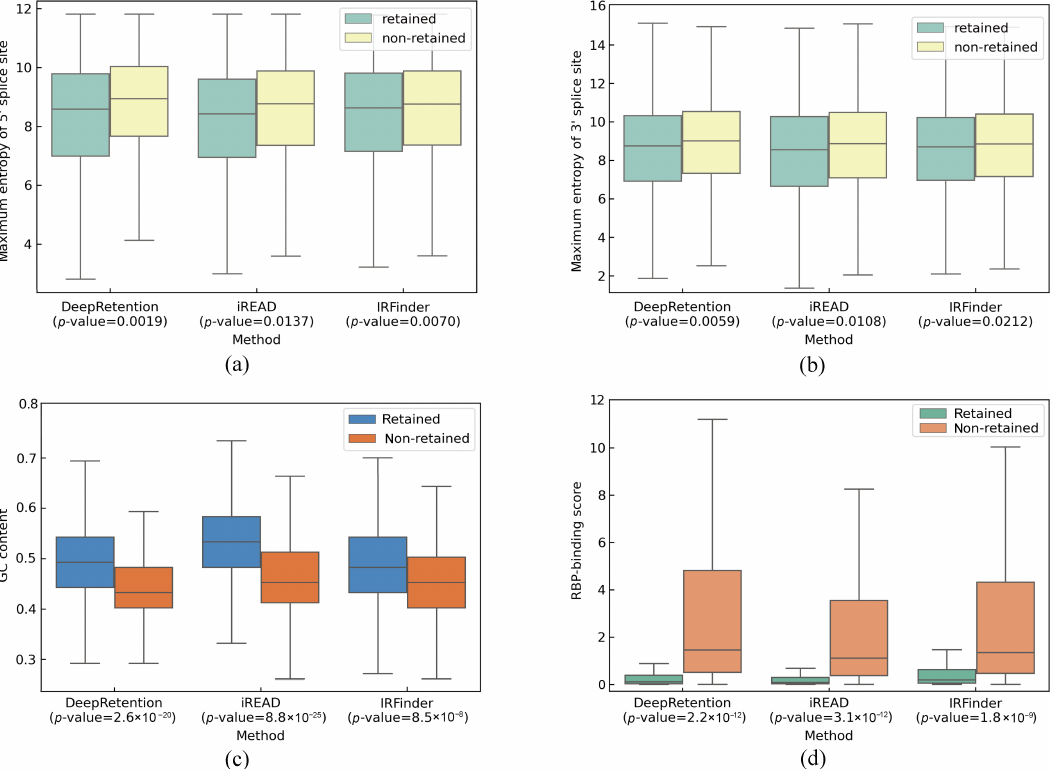
Fig. 3 Characteristics analysis of the retained introns obtained by different methods. (a) The boxplot shows the splicing strength of 5’ splice sites of retained introns and non-retained introns on the APPPS1 dataset. (b) The boxplot shows the splicing strength of 3’ splice sites of retained introns and non-retained introns on the APPPS1 dataset. The splicing strength is calculated by MaxEntScan [27] , which is based on the maximum entropy principle. (c) The boxplot shows the GC content of retained introns and non-retained introns on the APPPS1 dataset. (d) The boxplot shows the RBP-binding score within retained introns and non- retained introns on the GM12878S dataset. Since the collected RBPs are human RBPs, GM12878S is used for RBP-binding score calculation. The calculation method of the RBP-binding score is the same as the previous study [9] . Using the Mann-Whitney U test, the splicing strength, GC content, and RBP-binding score comparison between the retained and non-retained introns is made. The APPPS1 dataset is predicted by the model trained on GM12878S dataset, and the GM12878S dataset is predicted by the model trained on APPPS1